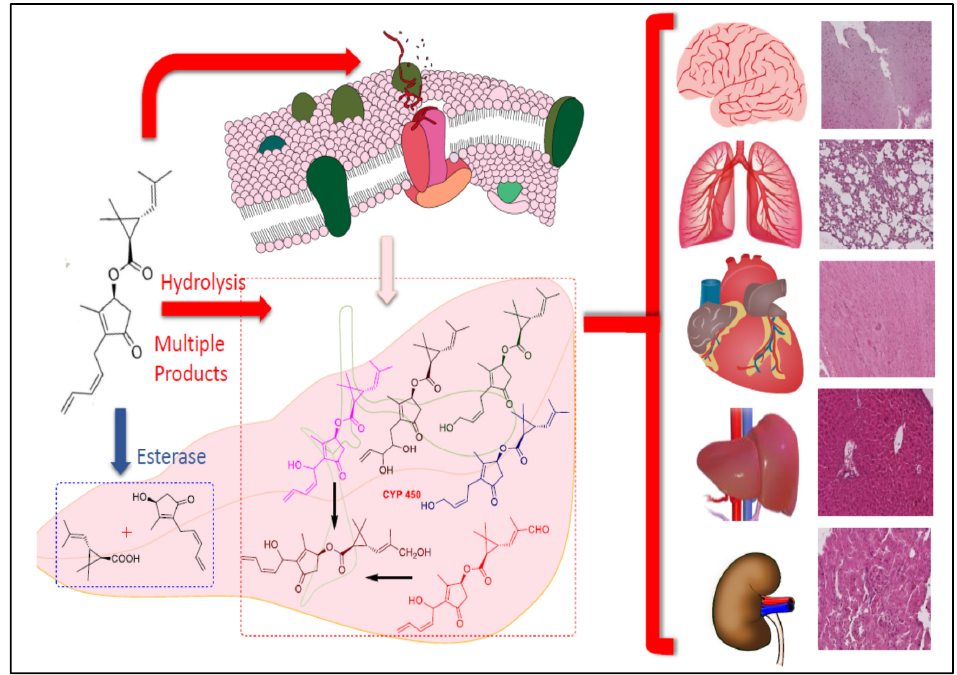
Figure 14. A representation of the metabolism of pyrethrins and organ damage.